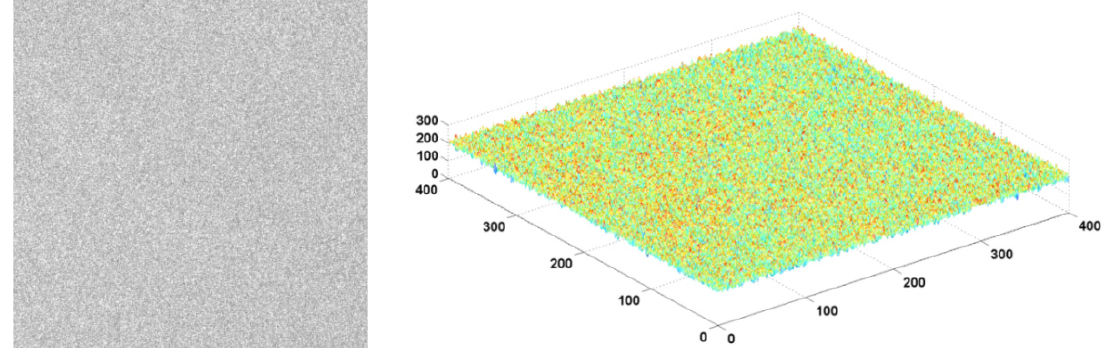
Figure 7. A laser illumination image with the speckle contrast of 7.9% ( left ) and 3D intensity distribution ( right ) based on a speckle-reduced 475/500 SUH500 multi-mode fiber.